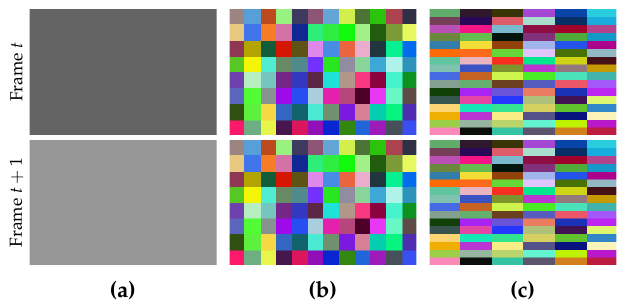
Figure 3. Supervoxel segmentation with different values for v x and v y . ( a ) two successive synthetic frames with constant colors; ( b ) supervoxels with v x = v y ; ( c ) supervoxels with v x = 4 v y ; In both ( b ) and ( c ), voxels with the same color form a supervoxel. Although ( b ) and ( c ) use different v x and v y , the number of the generated supervoxels are the same, but the shapes are very